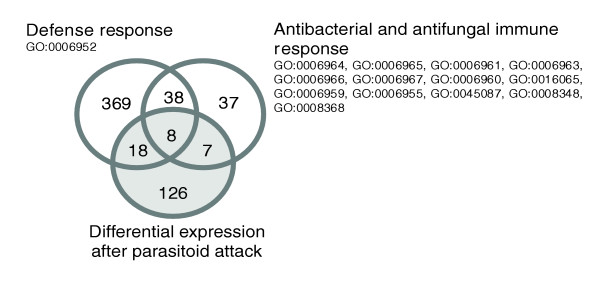
Venn diagrams of genes that changed expression after parasitoid attack and known immunity genes. The differentially expressed genes after parasitoid attack differed largely from those with a GeneOntology (GO) annotation for immunity or defense (GO database September 2004; the GO codes are also shown in the figure). Some of the probe sets in our set matched to multiple genes (see additional data files), thus reporting on the expression of potentially all of these genes. We included the multiple gene annotations per probe set to define our set of differentially expressed genes for the comparisons.